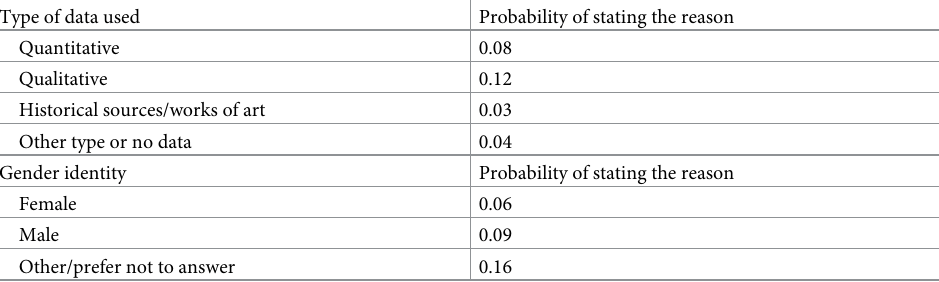
Table 13. Share of PhD students (predicted probabilities) who granted a guest authorship because “I believed they deserved it” ( n = 1,096). Type of data used